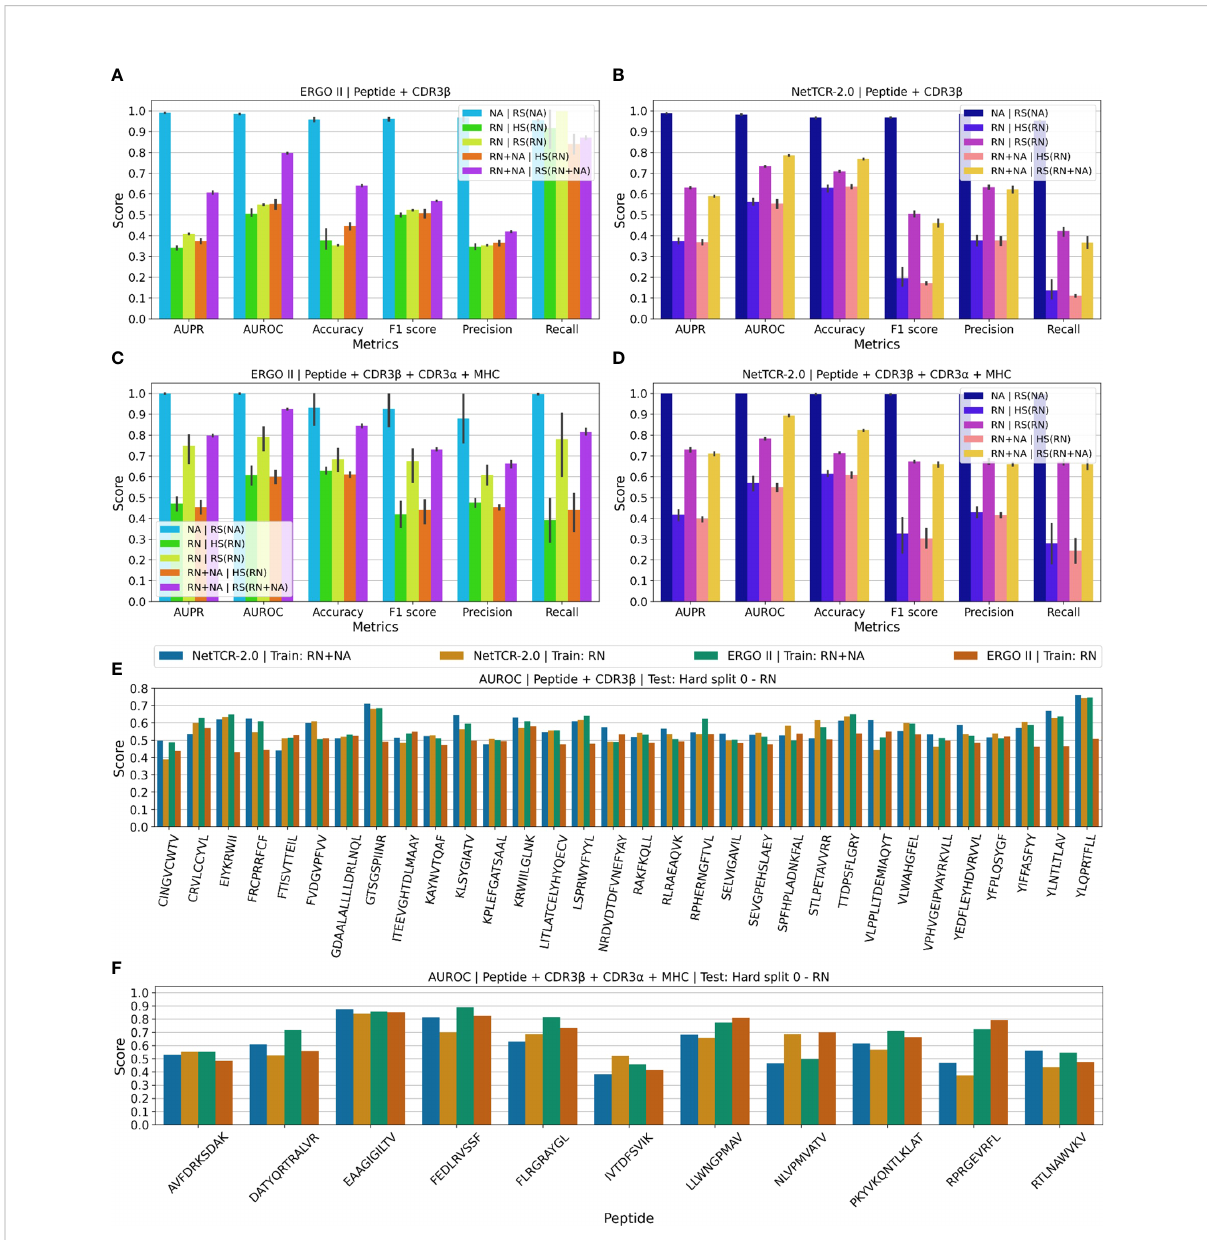
FIGURE 2 Test results for ERGO II and NetTCR-2.0 for TCR-peptide/-pMHC interaction prediction trained and tested on TChard . AUPR: area under the precision – recall curve. AUROC: area under the receiver operator characteristic curve. NA: negative samples from negative assays. RN: negative samples from random mismatching. RS(·): random split. HS(·): hard split. Con fi dence intervals are standard deviation over 5 experiments with independent training/test splits. (A – D) ERGO II and NetTCR-2.0 results on ( peptide, CDR3 b ) and ( peptide, CDR3 b , CDR3 a , MHC )